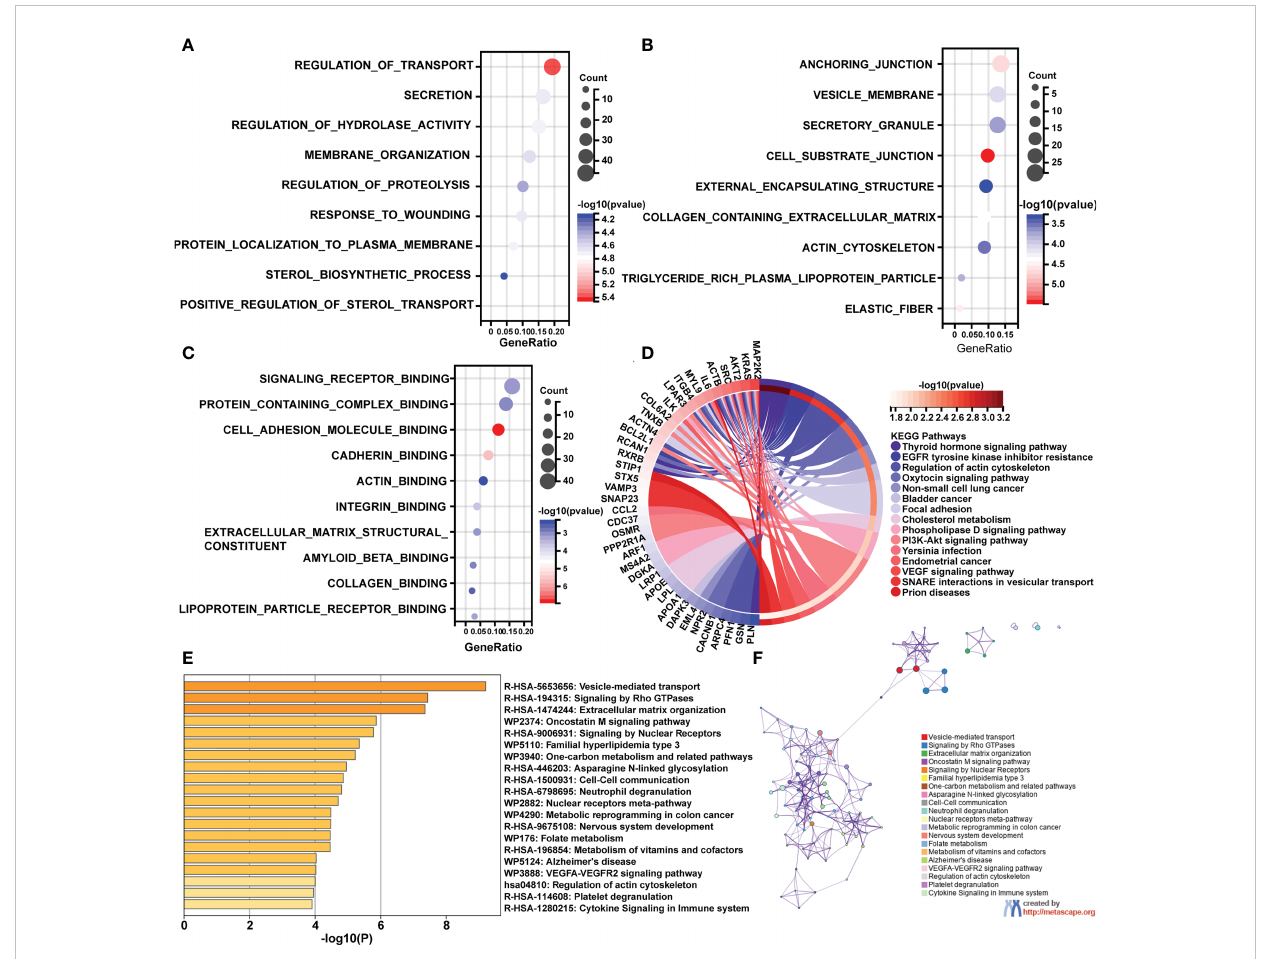
FIGURE 2 GO and KEGG pathway enrichment analyses of differentially expressed mRNAs (DEGs). (A) The bubble plot shows the top 10 enriched biological processes of DEGs. (B) The bubble plot shows the top 10 enriched cellular components of DEGs. (C) The bubble plot shows the top 10 enriched molecular functions of DEGs. (D) The chord plot shows the most enriched KEGG pathways of DEGs. (E, F) The KEGG pathway enrichment analysis of DEGs using